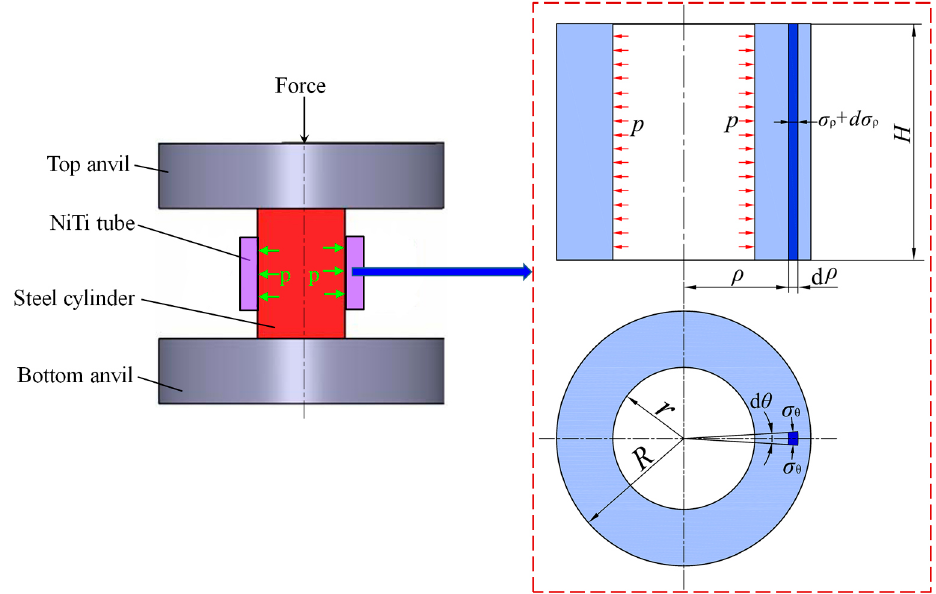
Figure 2. Mechanical model of NiTi SMA tube subjected to radial loading, where p is the pressure, R the outer radius, r the inner radius, and H the height.